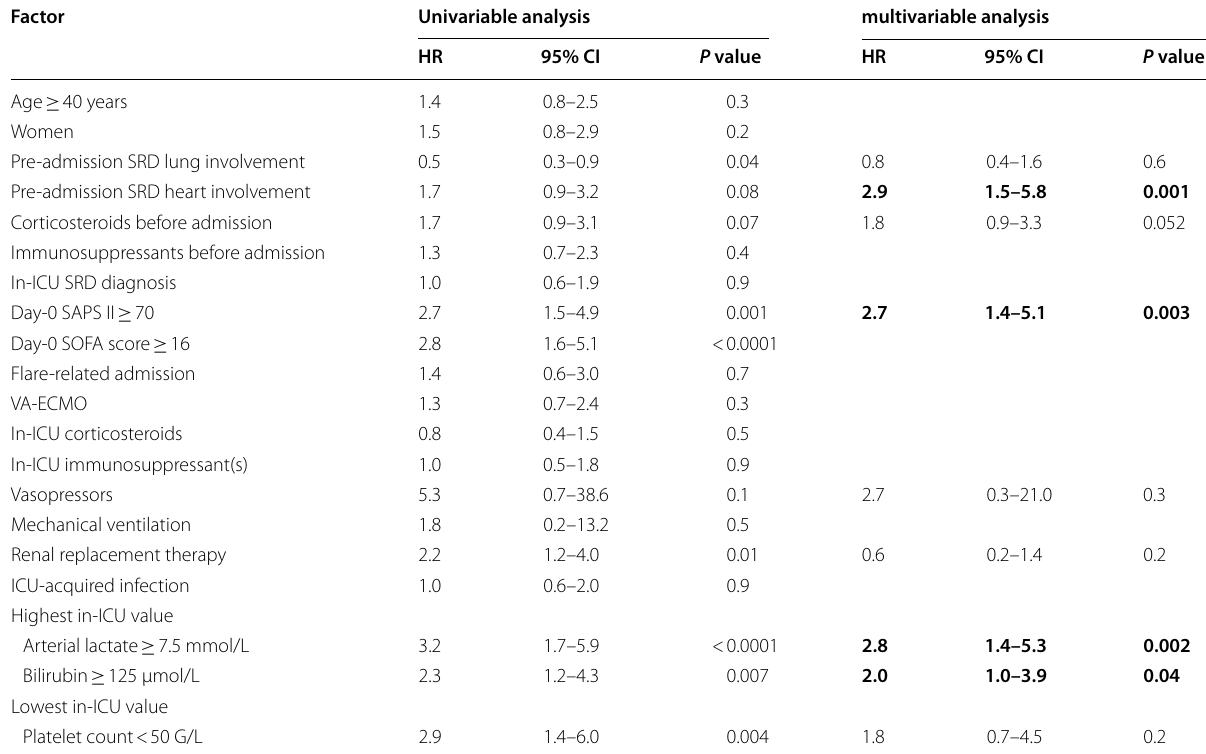
Table 3 Univariable and multivariable analyses of factors associated with in-hospital mortality for the 90 ECMO-treated SRD